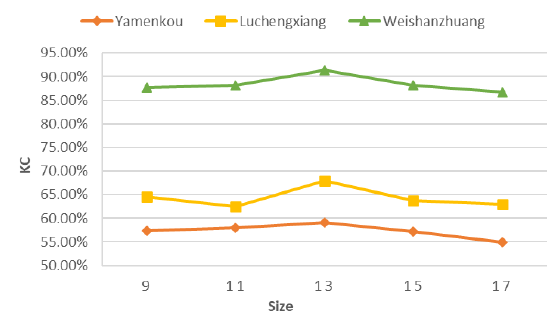
Figure 11. Comparisons of KC with varying neighbourhood